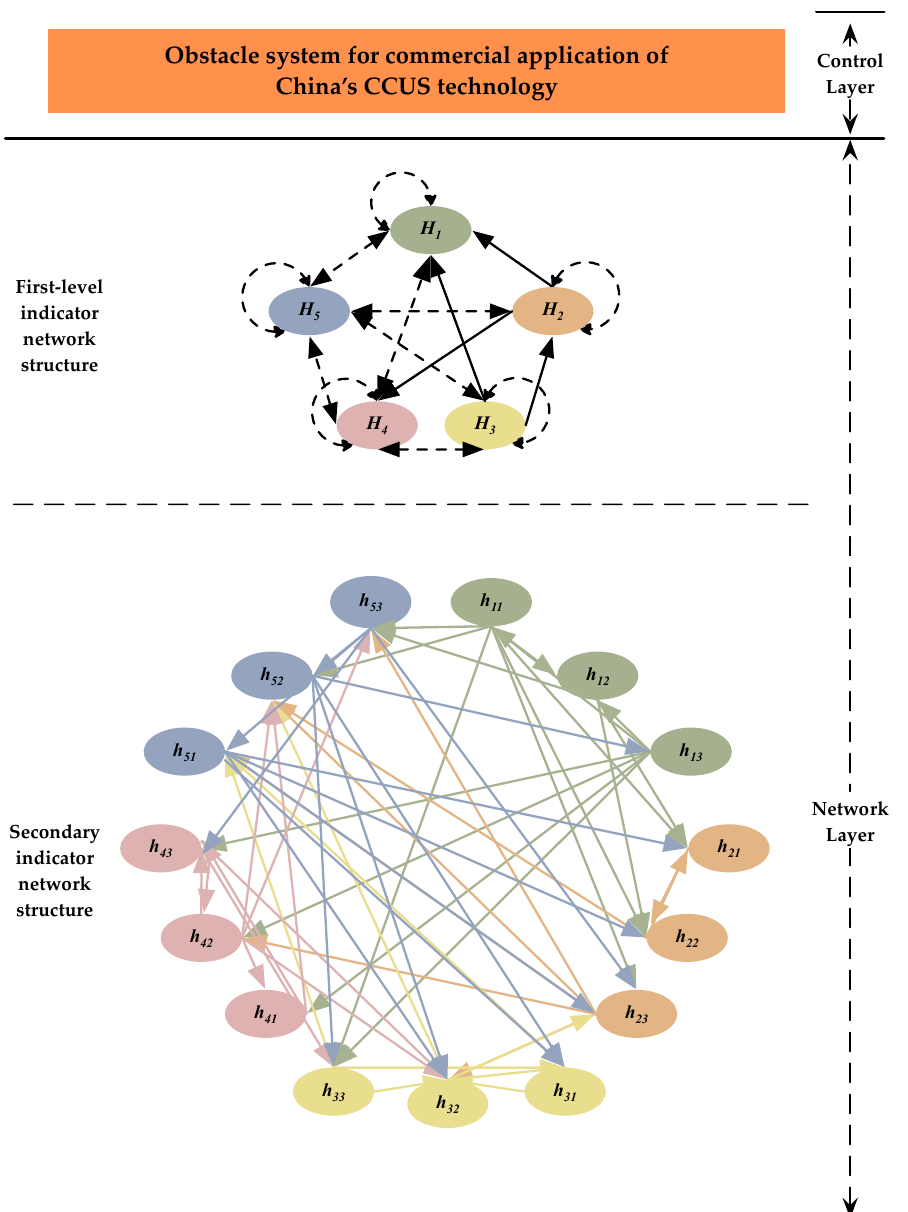
Figure 4. The ANP network hierarchy of the obstacle system (Solid lines represent a one-way impact, dashed lines represent a two-way impact). Table 2. Influence relationship among second-level indicators.